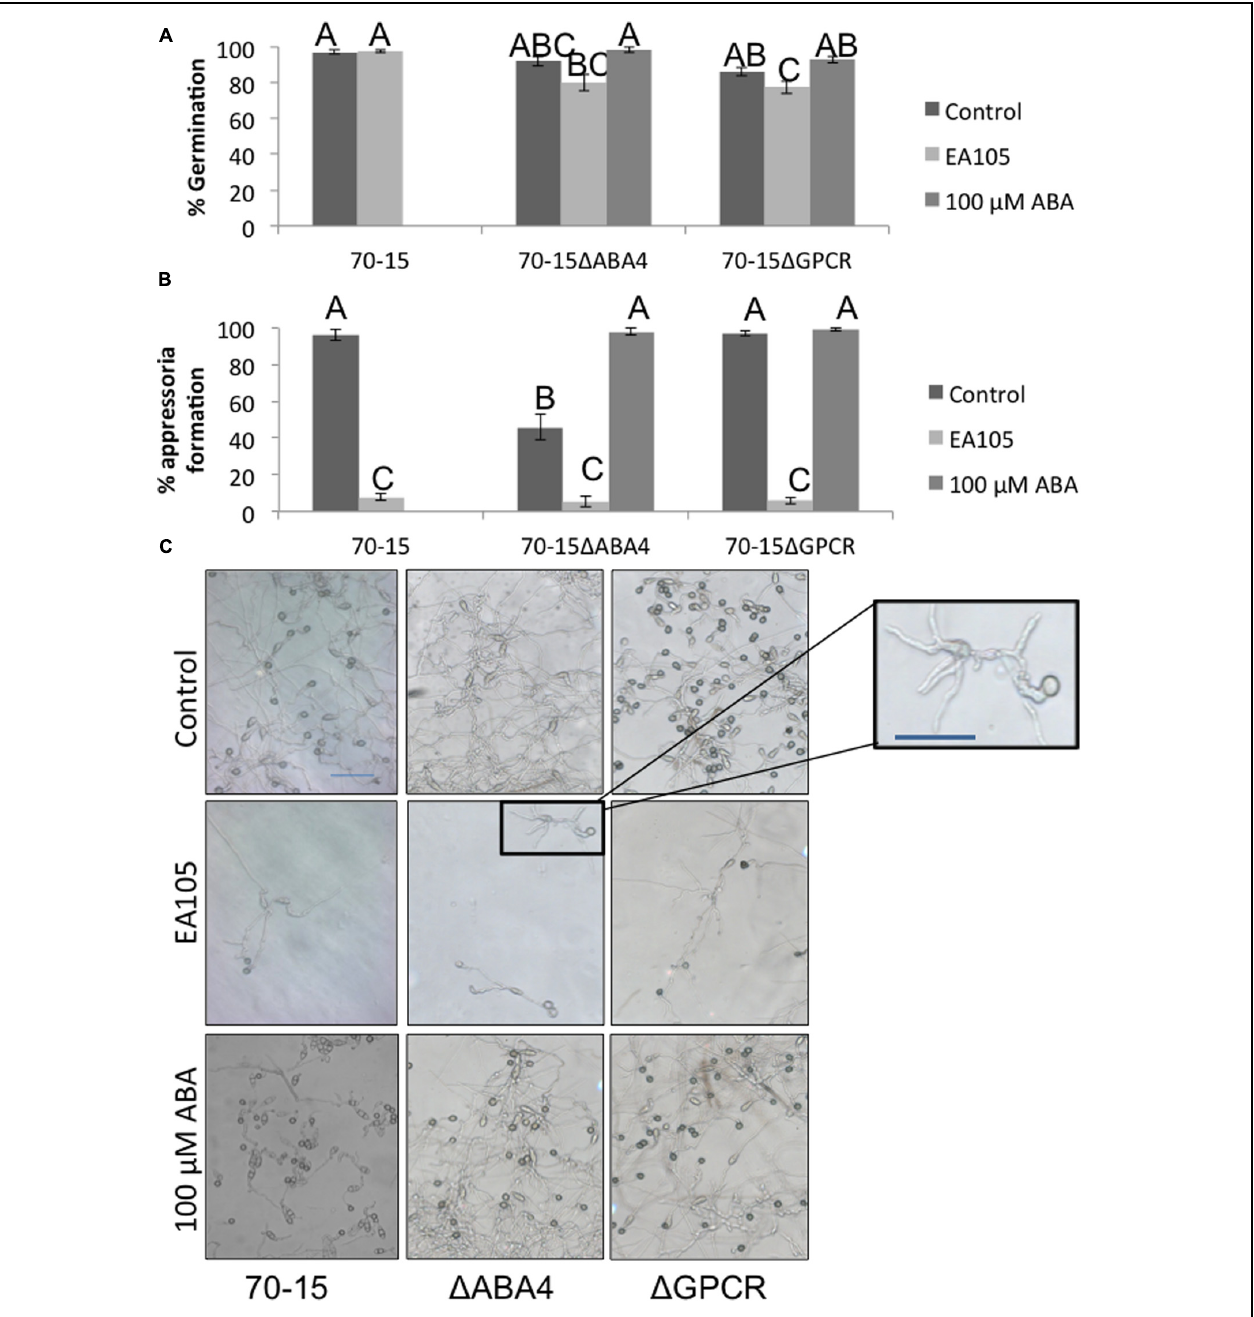
FIGURE 6 | Spore germination and appressoria formation in 70-15 and ABA mutants. (A) Spore germination was measured 3 h after resuspension and incubation on a hydrophobic plastic coverslip. (B) Appressoria formation was measured at 24 h. (C) Light microscope images were taken in areas which were dense with spores (top row) as well as in sparse areas where individual spores could be discerned. An enlarged imaged of the ABA4 mutant is displayed to show the hyperbranching phenotype. Scale bars are 50 μ M. Supplementation of ABA (100 μ M) reverts the phenotype in ABA4 mutant. Different letters represent statistical significance based on the Tukey-Kramer test ( p <